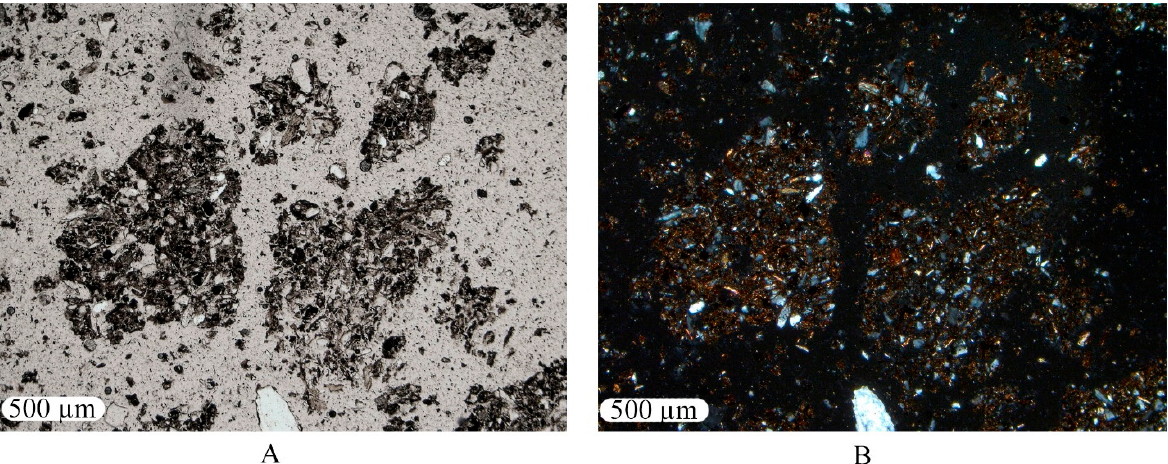
Figure 7. Micromorphological structure of the arable soil Y11 Ah profile. ( A ) plane polarized light; ( B ) crossed polarized light.